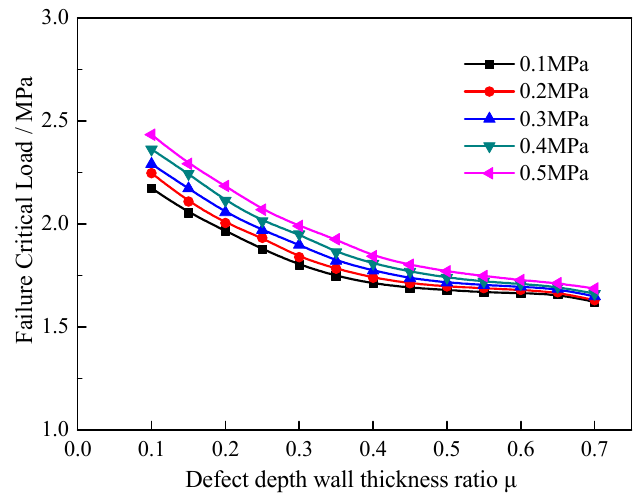
Figure 16. Critical failure load of HDPE pipeline for various defect depths.